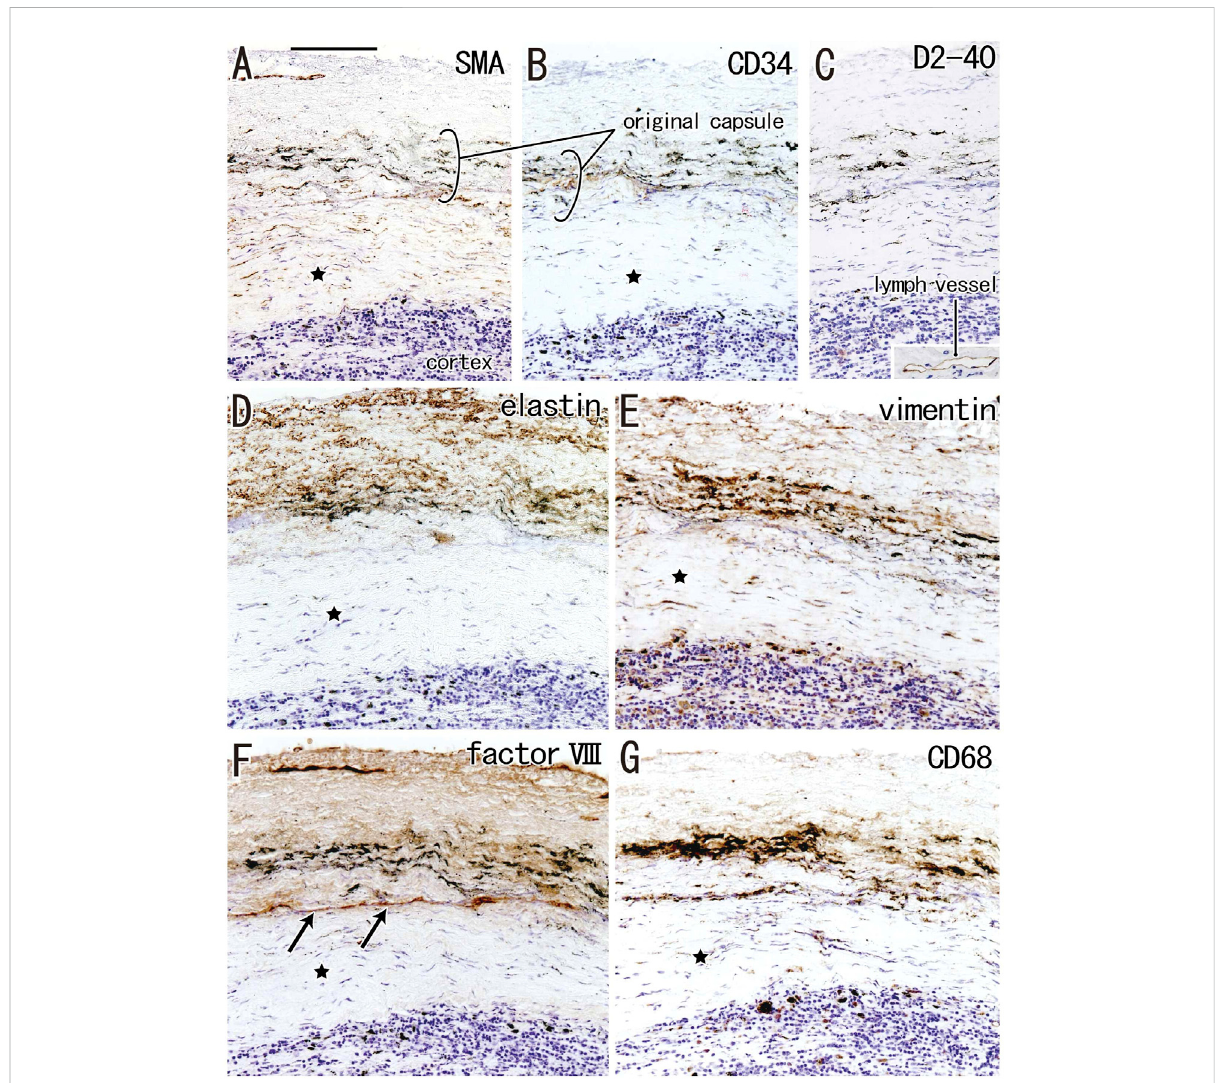
FIGURE 6 Immunohistochemistry ofthesubcapsular sinus hyalinization.NearsectionsofFigure5A andhigher magni fi cation viewsofasiteindicatedbya square in Figure 5B (an interlobar node removed from a 78-years-old man). The DAB reaction made the positive cells brown. According to immunostainings of smooth muscle actin (SMA) and CD34 (A,B) , the original nodal capsule is separated from the surface cortex by a thick fi brous zone (star). No reactivity is seen for D2-40 [podoplanin; (C)] except for lymph vessels around the node [insert at the bottom of (C) ]. Abundant elastin-positive fi bers (D) are seen in the outside of the original capsule (cf., Figure 2B). Vimentin reactivity is much stronger in the original capsule than the usual morphology (cf., Figure 2E). The fi brous zone (star) contains slender cells positive for SMA (A) or vimentin (E) . Conversely, the fi brous zone is negative for elastin, factor VIII or CD34. Notably, a factor VIII-positive fi ber bundle delimits the fi brous zone [arrows in (F) ]. No or few macrophages are seen in the zone (G) . Slender macrophages carry carbon particles (anthracotic macrophages). All panels, including an insert in (C) , were prepared at the same magni fi cation [scale bar in (A) , 0.1